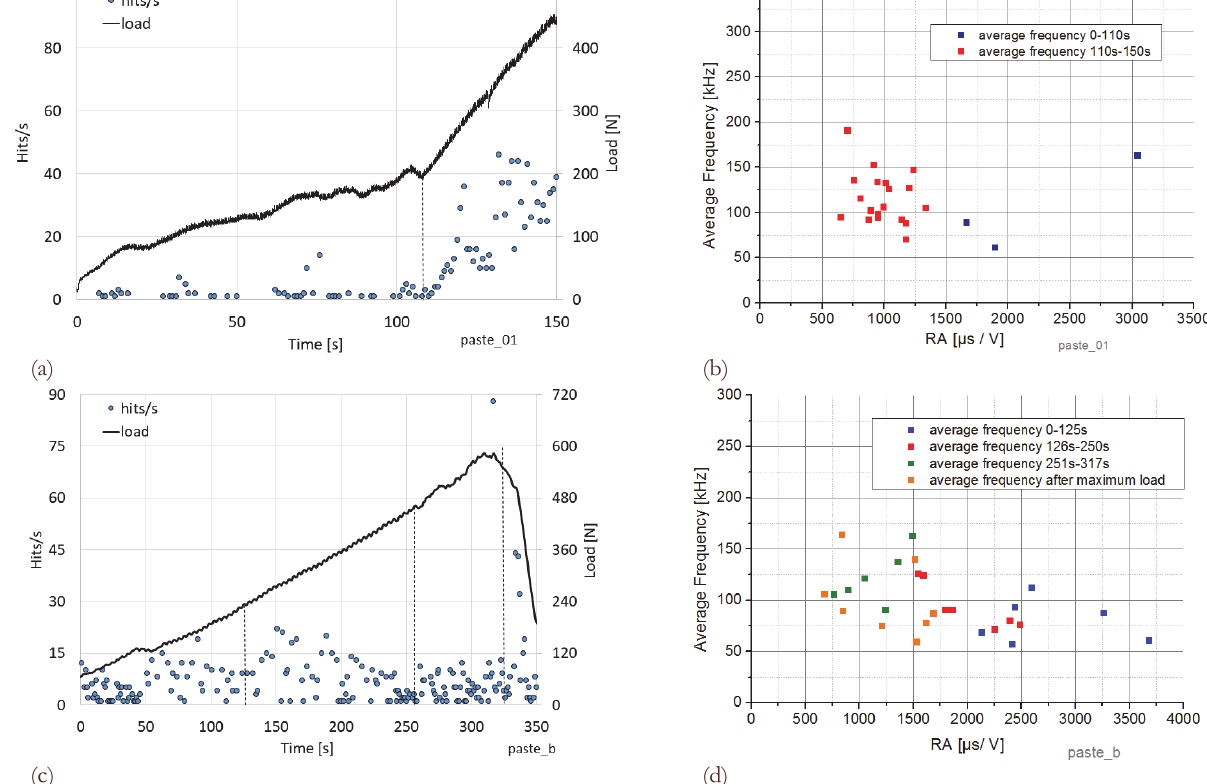
Figure 11: (a) Time variation of the hits /s and the load applied for a cement paste specimen and (b) the respective average frequency versus RA; (c) Time variation of the hits /s and the load applied for a cement paste specimen with a clearly distinguishable post-peak regime and (d) the respective average frequency versus